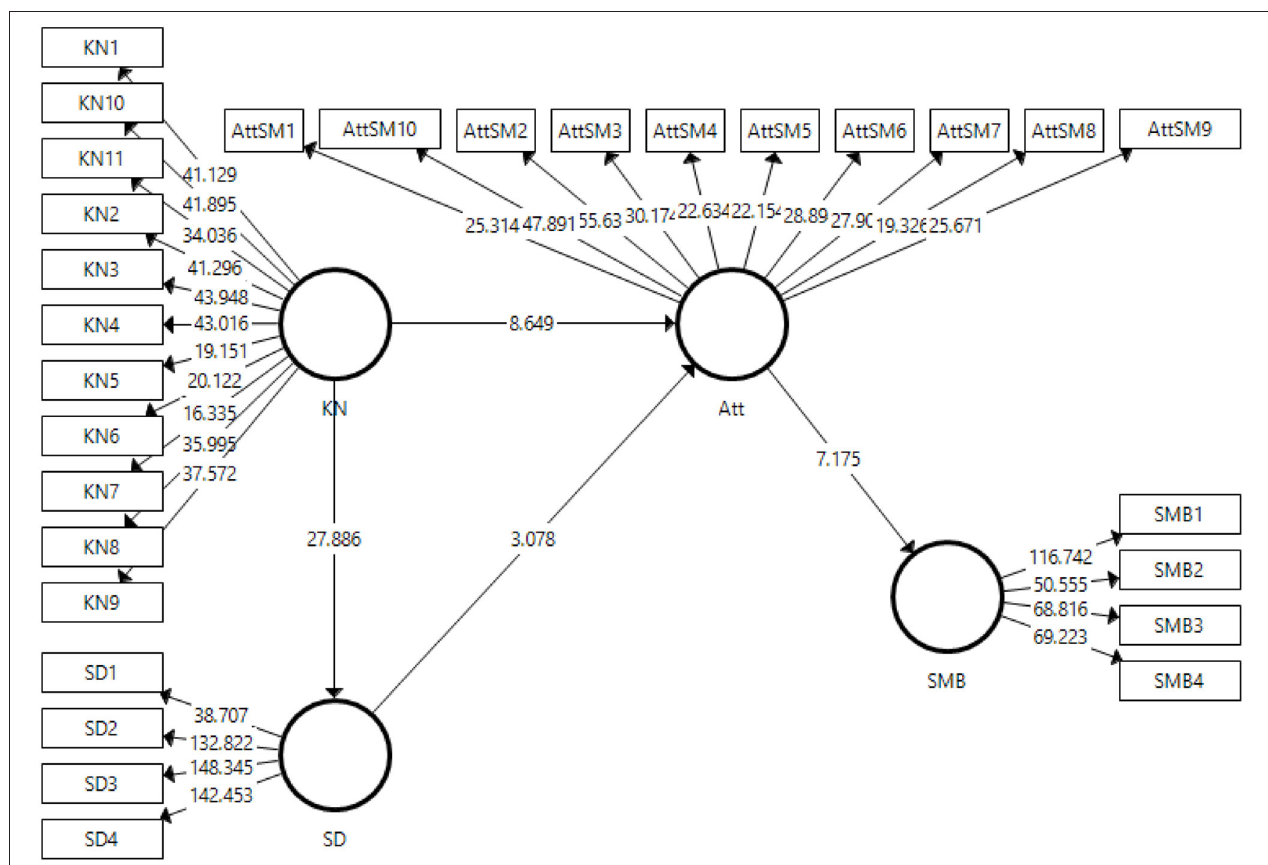
FIGURE 3 | Structural model algorithm.